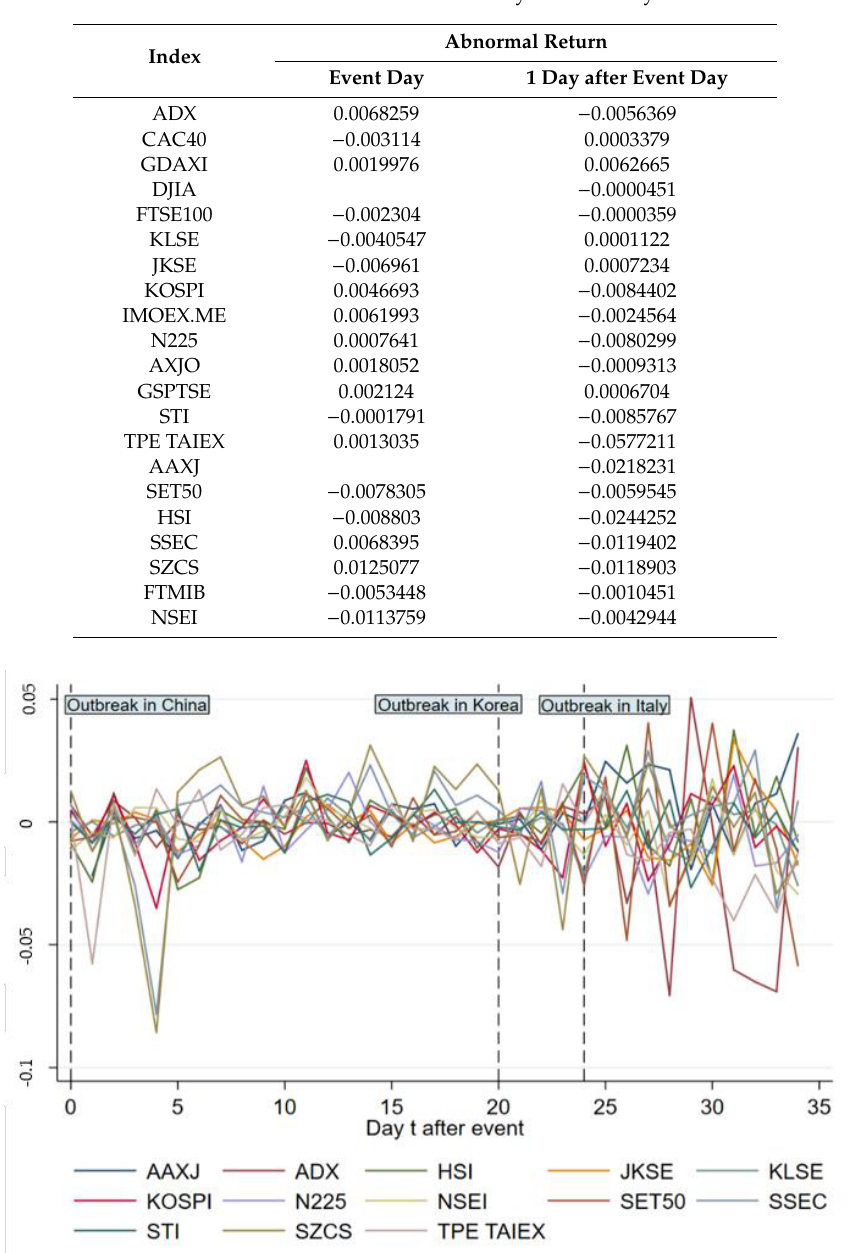
Figure 3. Cumulative abnormal return (CAR) change of main indices in Asia from day 0 to 34. Figure 4 and Figure 5 exhibit ARs and CARs of main indices out of Asia from day 0 to 34. As is shown in Figure 4, the ARs witness violent fluctuations relatively except those of GSPTSE for Canada and DJIA for America, with a drastic “up and down” between day 3 and day 5. After day 24, a violent fluctuation occurs across all indices showing an obvious negative influence on ARs. Figure 5 indicates that before day 24 there is no significant effect on CARs except a gentle decline and increase for IMOEX.ME and FTMIB respectively. After day 24, CARs of most indices decrease in general.